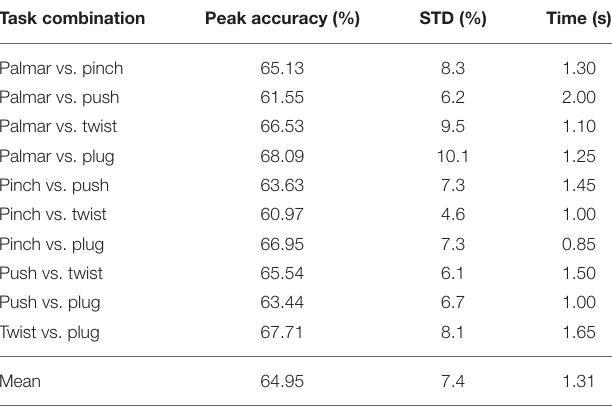
TABLE 2 | Grand average peak performance for each reach-and-grasp combinations and time of occurrence (s) with respect to the movement onset. Task combination Palmar vs. pinch Palmar vs. push Palmar vs.